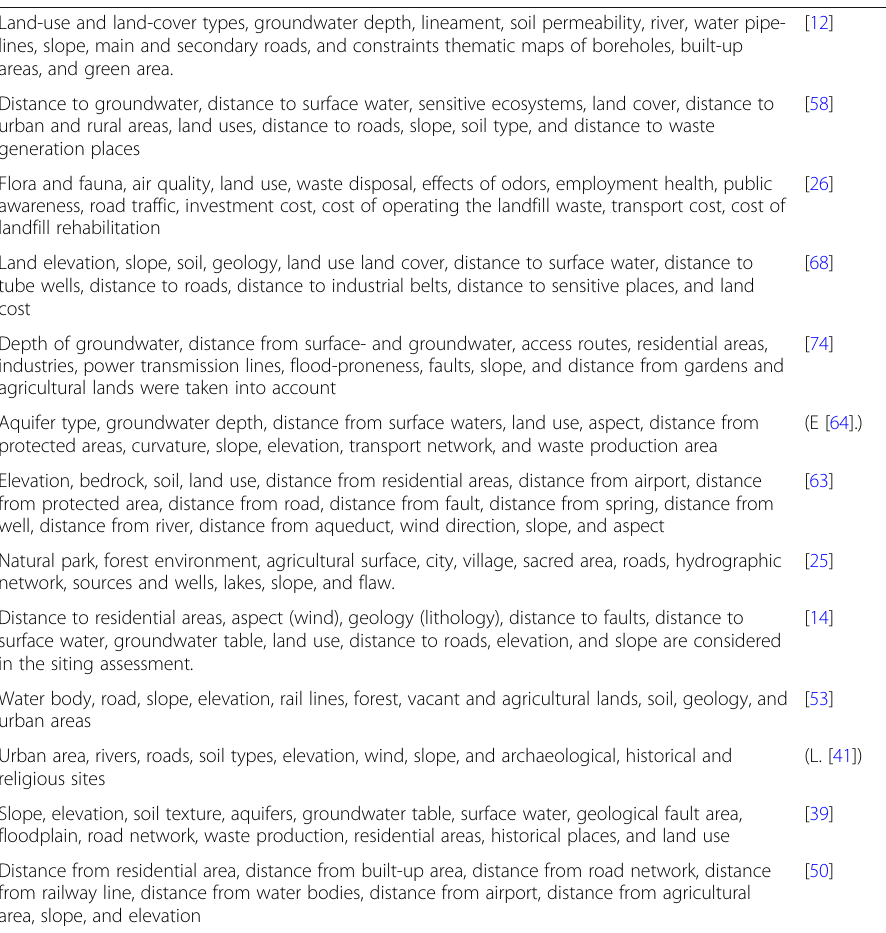
Table 1 Subcriteria selected according to standard site selection methods Subcriteria